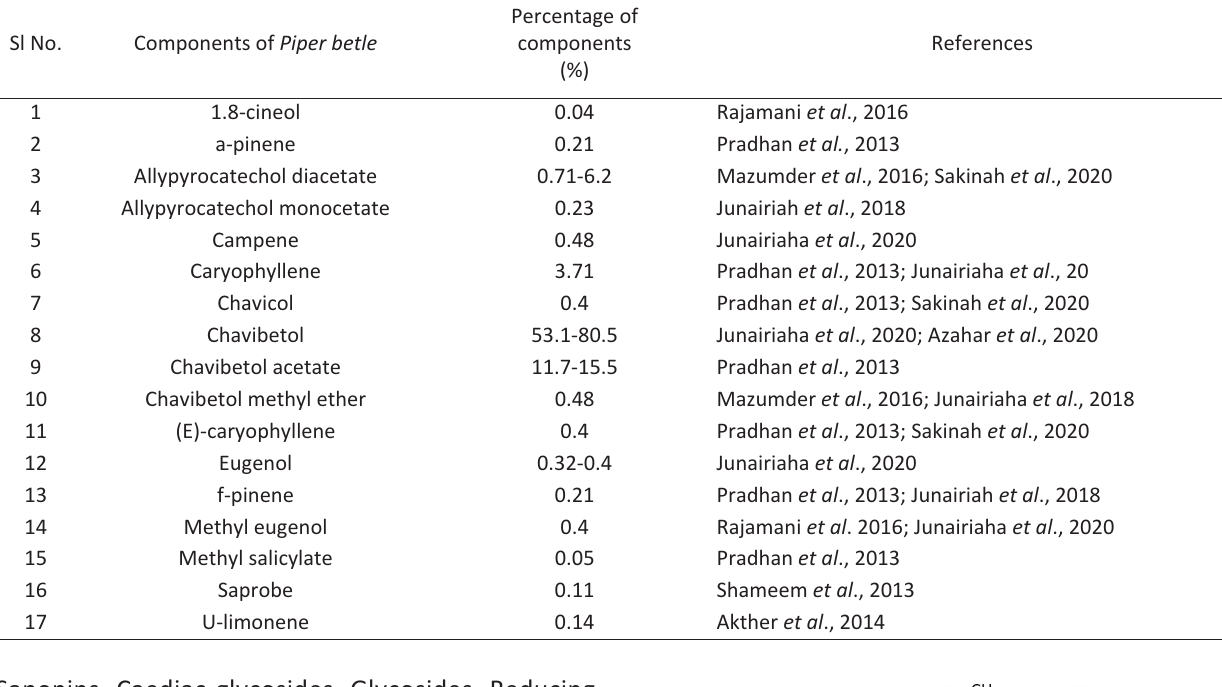
Table 1 ­ Components of Piper betle